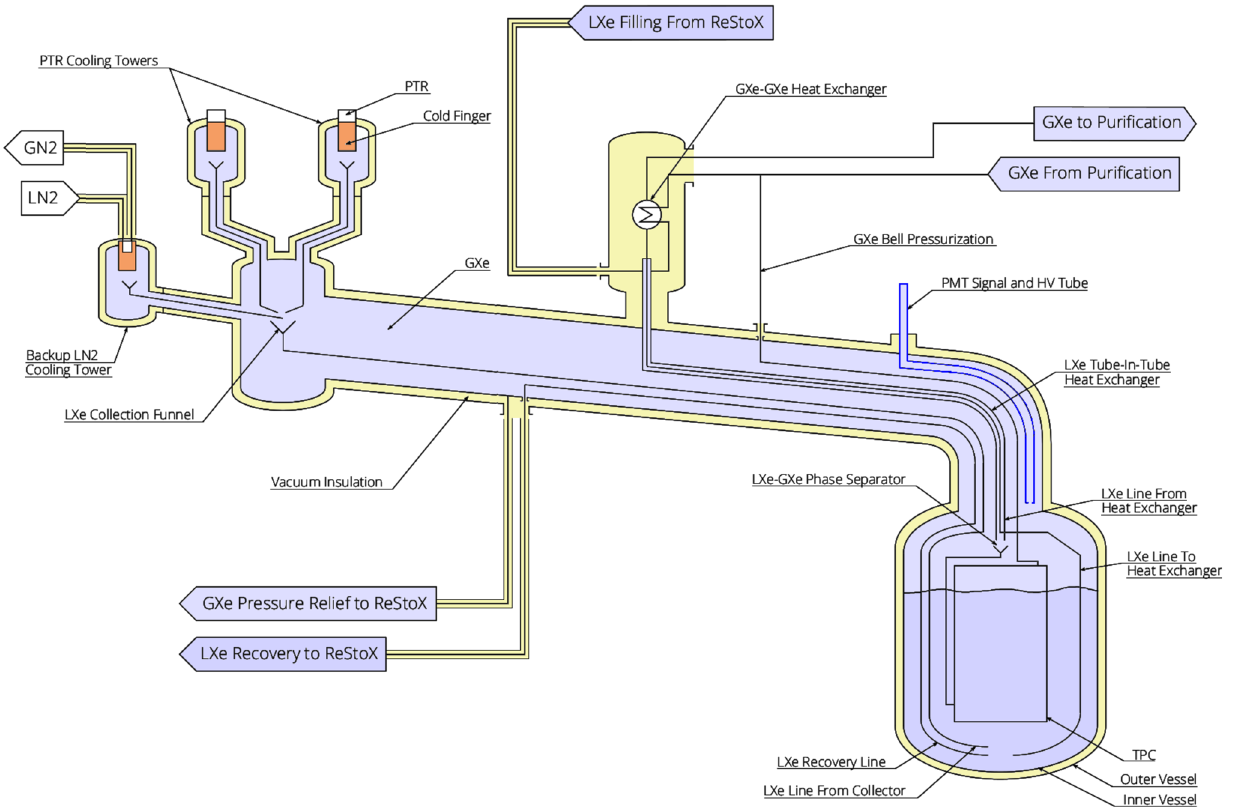
Fig. 7 The cryogenic system of XENON1T: cooling is provided by means of three redundant cold heads (two pulse-tube refrigerators (PTR), 1 LN 2 ), installed on individual cooling towers located outside of the water shield. The liquefied xenon runs back to the main cryostat in a 6m long vacuum-insulated cryogenic pipe, through which all con-